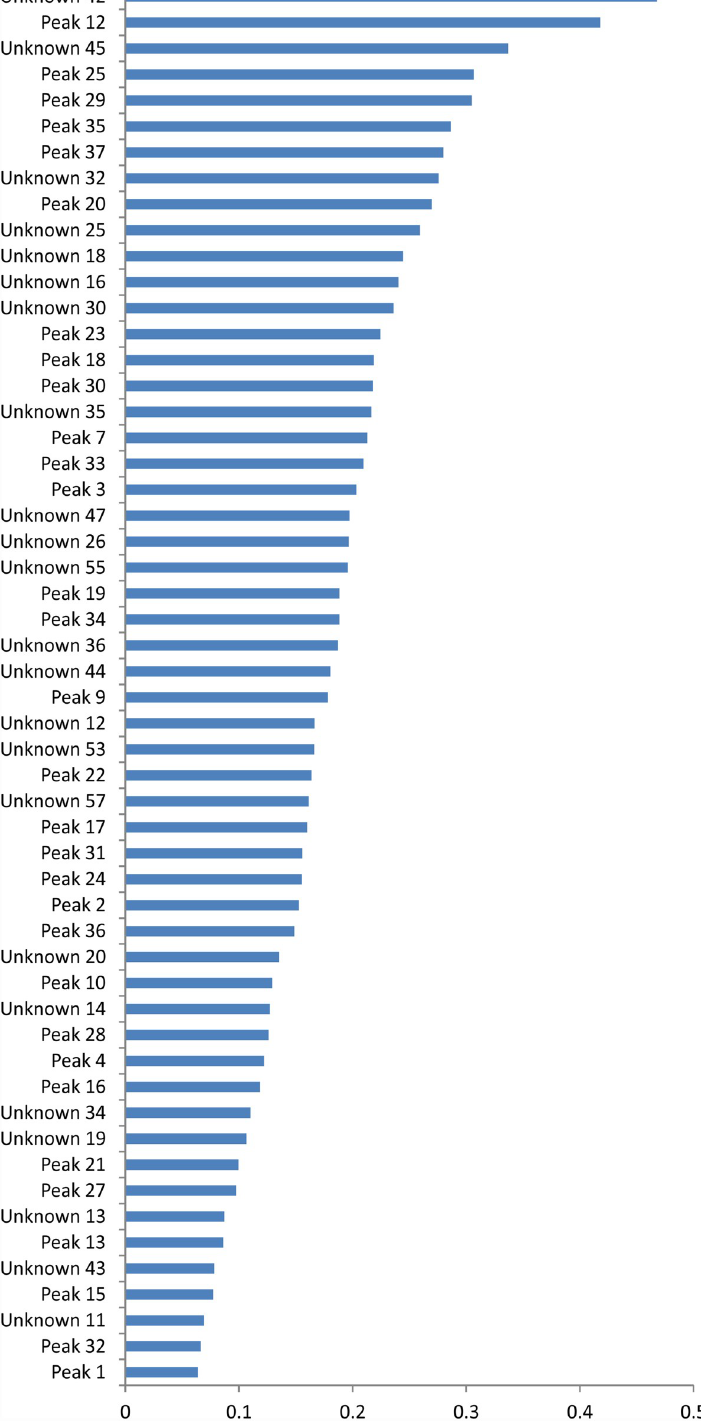
PLOS ONE | https://doi.org/10.1371/journal.pone.0211237 January 25,